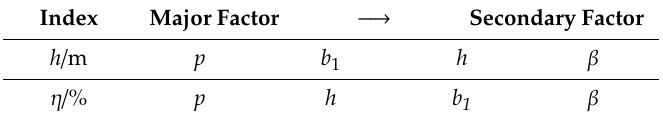
Table 16. The order of influence of the gap geometry parameters on pump performance at 1.4 Q . Index Major Factor −→